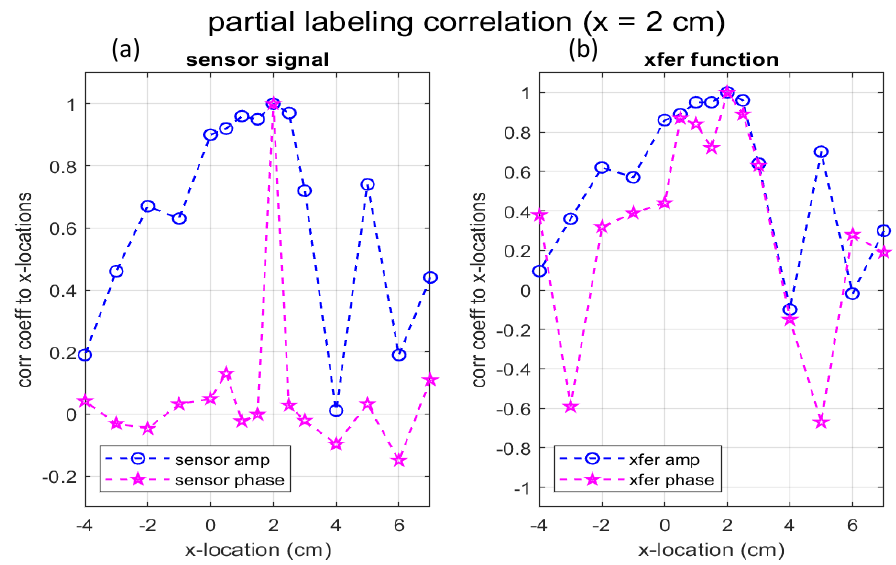
Figure 19. ( a ) sensor signal amplitude and phase, ( b ) transfer function amplitude and